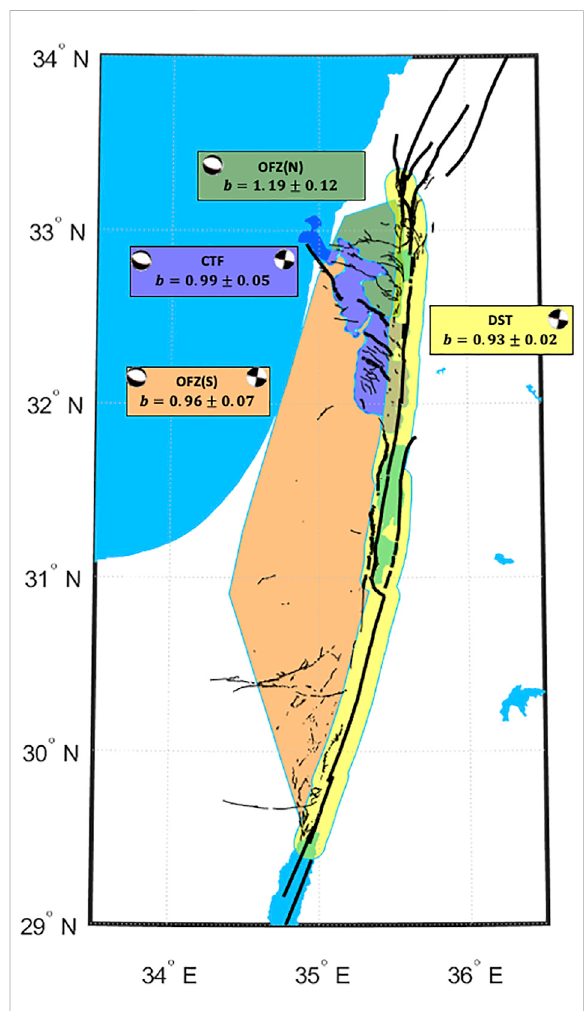
geodetic observations (see text for further